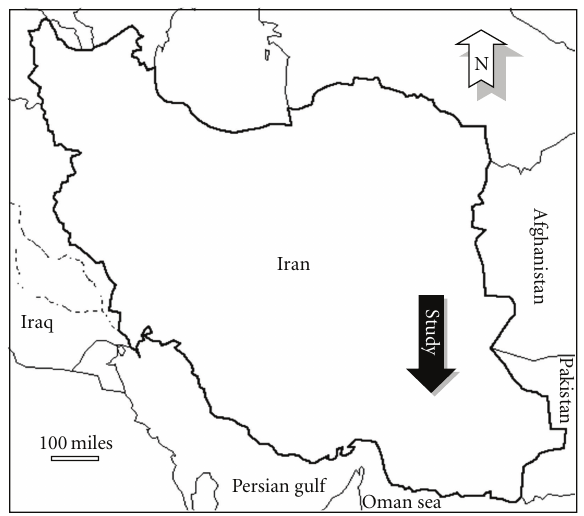
Figure 1: Location of malarious area where the study has been done, in southern